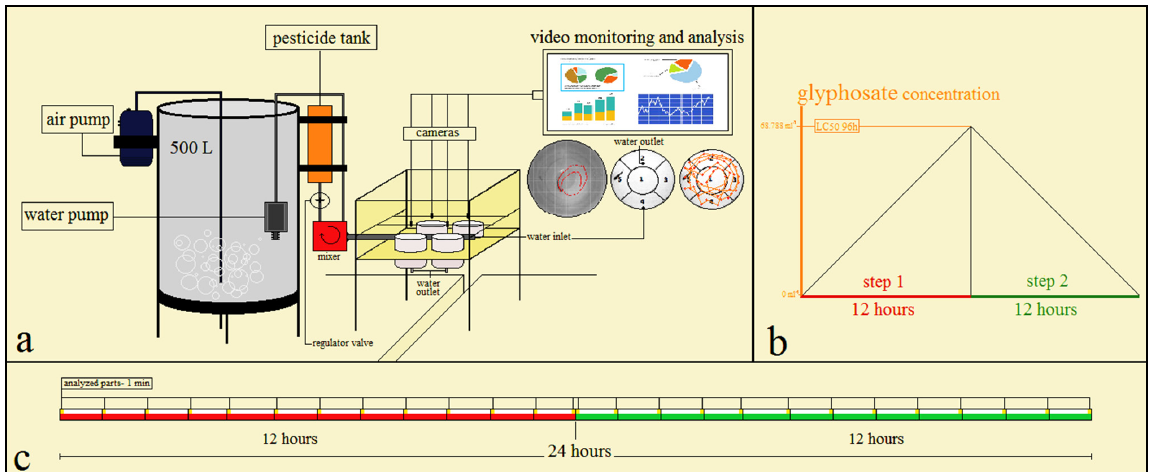
Figure 1. Schematic description of the test environment and its stages. ( a ) System design and components of the test. ( b ) Steps of the test; concentration of glyphosate suspension was increased and reached the 96 h LC 50 during step 1, then was decreased and reached 0 mL ∙ L − 1 during step 2. ( c ) The timeline of the behavioral test: each step was 12 h and there were 26 time points. The behavior test was a dynamic test. The fish swimming was recorded at these time points of 1 min duration. The water flow during the test was 416.667 mL ∙ h − 1.